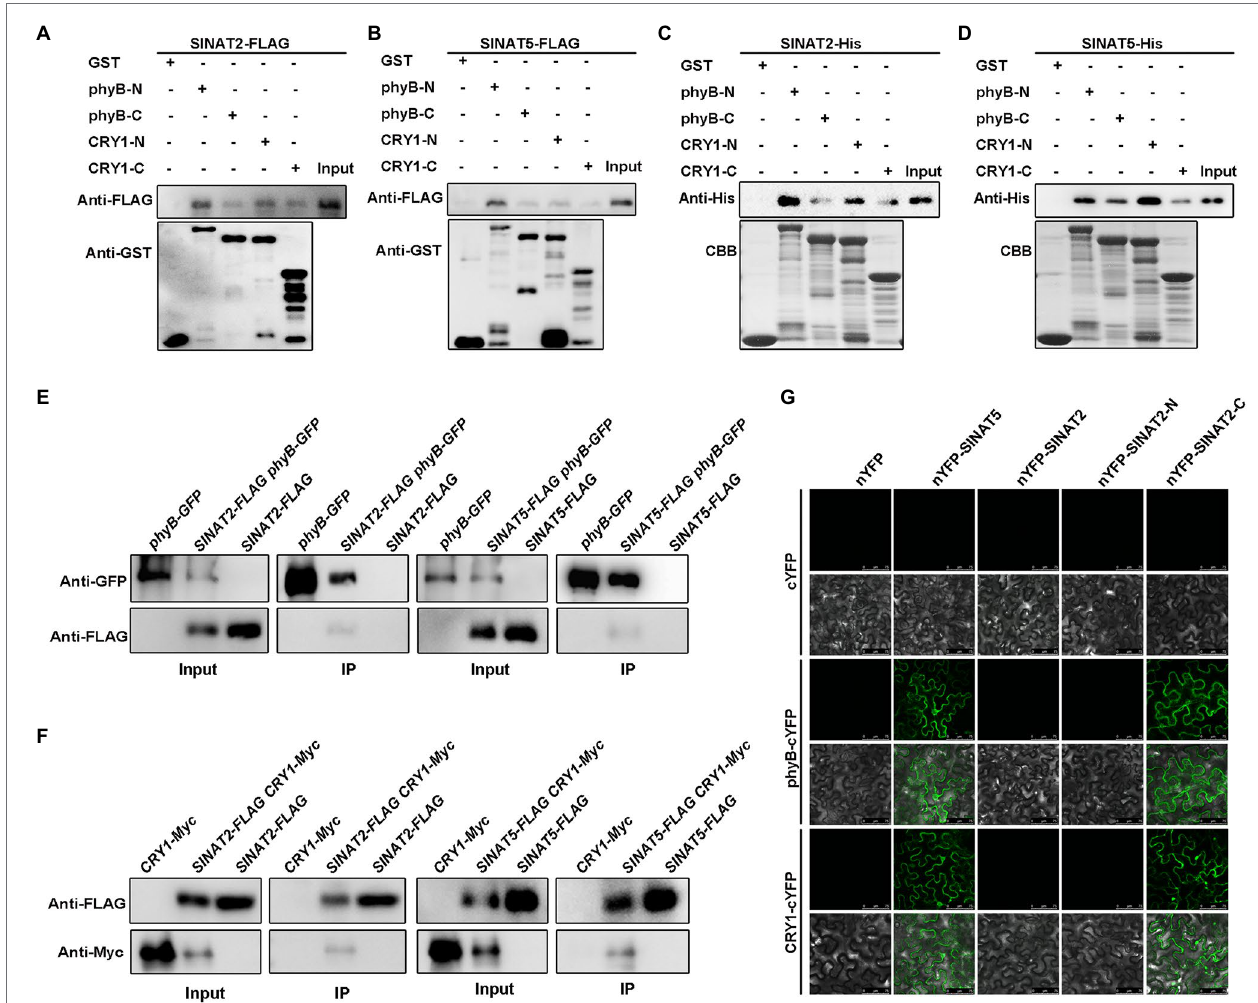
FIGURE 2 | SINATs interact with phyB and CRY1. (A) Interaction of SINAT2 with phyB-N/phyB-C and CRY1-N/CRY1-C by semi- in vivo pull-down assays. (B) Interaction between SINAT5 and phyB-N/phyB-C or CRY1-N/CRY1-C detected by semi- in vivo pull-down assays. (C) Interaction between SINAT2 and phyB-N/ phyB-C or CRY1-N/CRY1-C detected by in vitro pull-down assays. Approximately equal loading of the recombinant proteins was determined by Coomassie Brilliant Blue (CBB) staining. (D) Interaction between SINAT5 and phyB-N/phyB-C or CRY1-N/CRY1-C detected by in vitro pull-down assays. (E) Interaction between SINAT2 or SINAT5 and phyB detected by co-immunoprecipitation (Co-IP). The phyB-GFP was immunoprecipitated with anti-GFP gel, and the co- immunoprecipitated SINAT2-FLAG or SINAT5-FLAG was detected by Western blotting (WB) with anti-FLAG antibodies. (F) Interaction between SINAT2 or SINAT5 and CRY1 detected by Co-IP. The SINAT2-FLAG or SINAT5-FLAG was immunoprecipitated with anti-FLAG agarose, and the co-immunoprecipitated CRY1-Myc was detected by Western blotting (WB) with anti-Myc antibodies. (G) Interaction between SINAT2 and SINAT5 with phyB and CRY1 in bimolecular fluorescence complementation (BiFC) assays. The indicated constructs were transformed into pavement cells of Nicotiana benthamiana